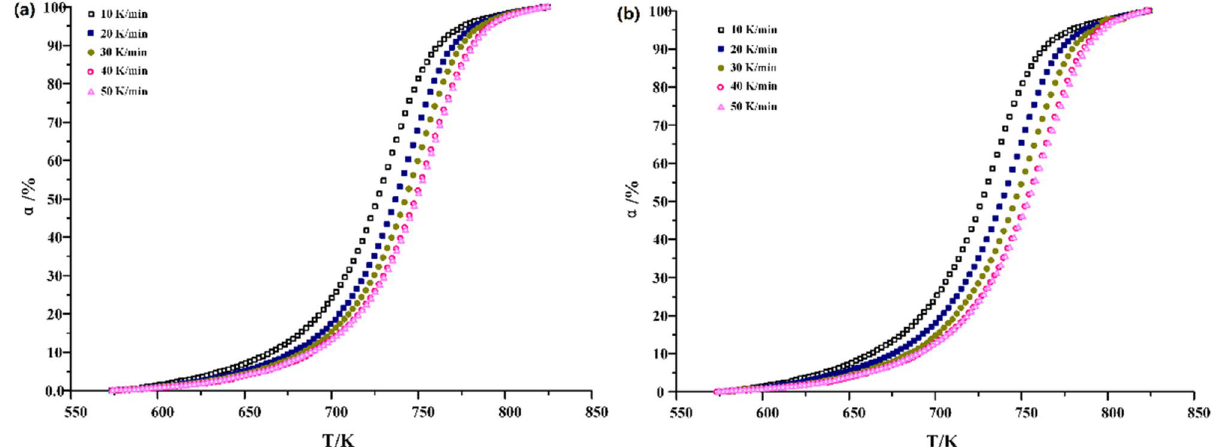
Figure 4. Conversion of oil shale pyrolysis in the second stage under ( a ) N 2 and ( b ) CO 2 .